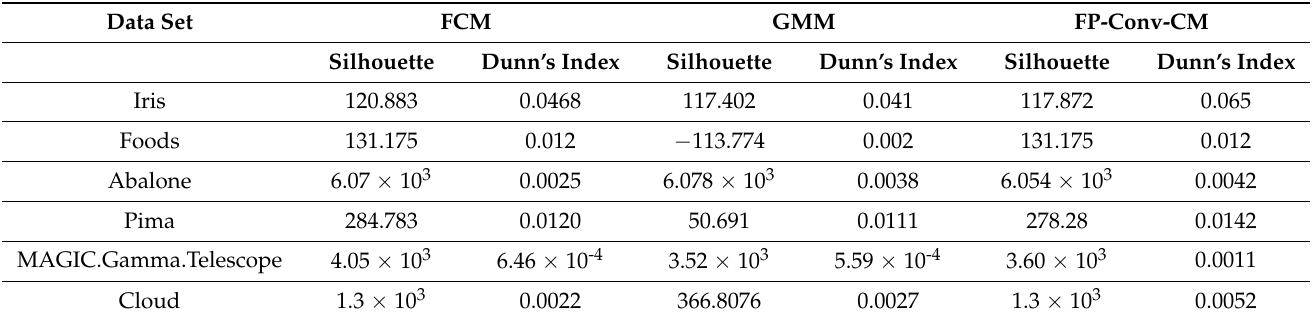
Table 2. Dunn’s index and Silhouette of FCM, GMM, and FP-Conv-CM on different